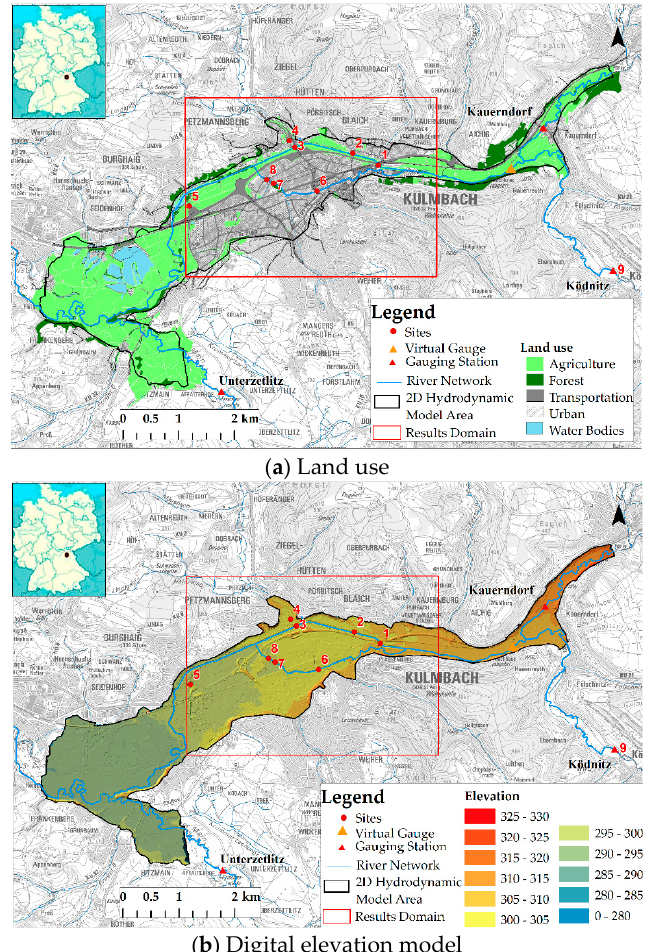
Figure 2. Study area ( a ) Land use and ( b ) digital elevation model of the city Kulmbach. Data source: Water Management Authority Hof.